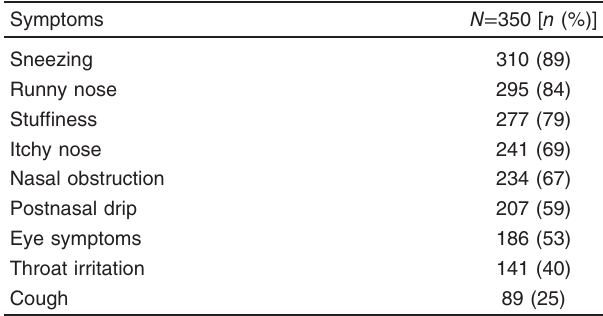
Table 1 Allergic nasal and extranasal symptoms among the study group Symptoms